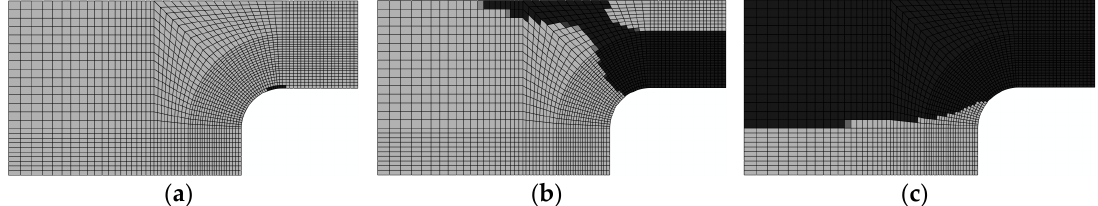
Figure 14. Matrix fracture damage of repaired fiber caused by transverse tension or shear ( − 45 ◦ ): ( a ) 155 kN; ( b ) 178 kN; and ( c ) 213.1 kN.